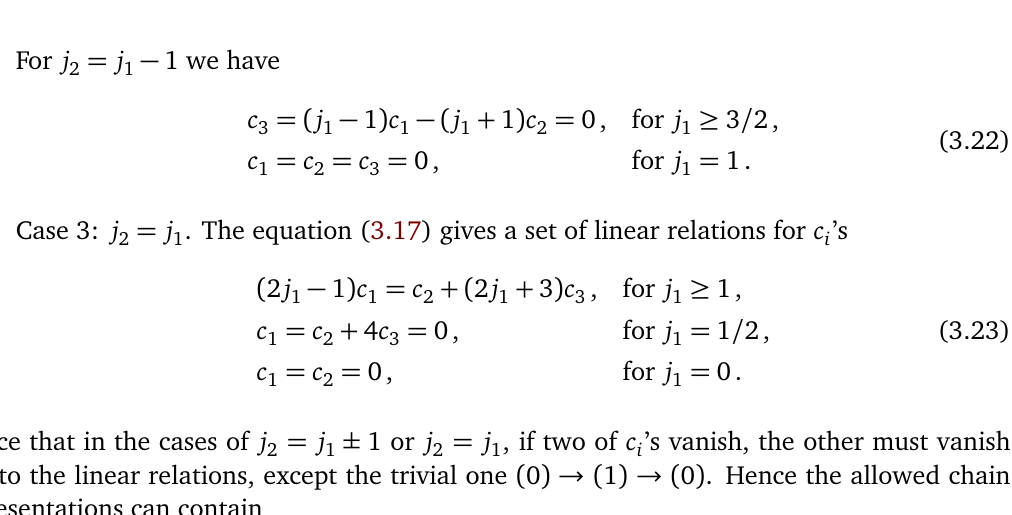
Figure 8: Basis change for a 2 d GCA representation to chain